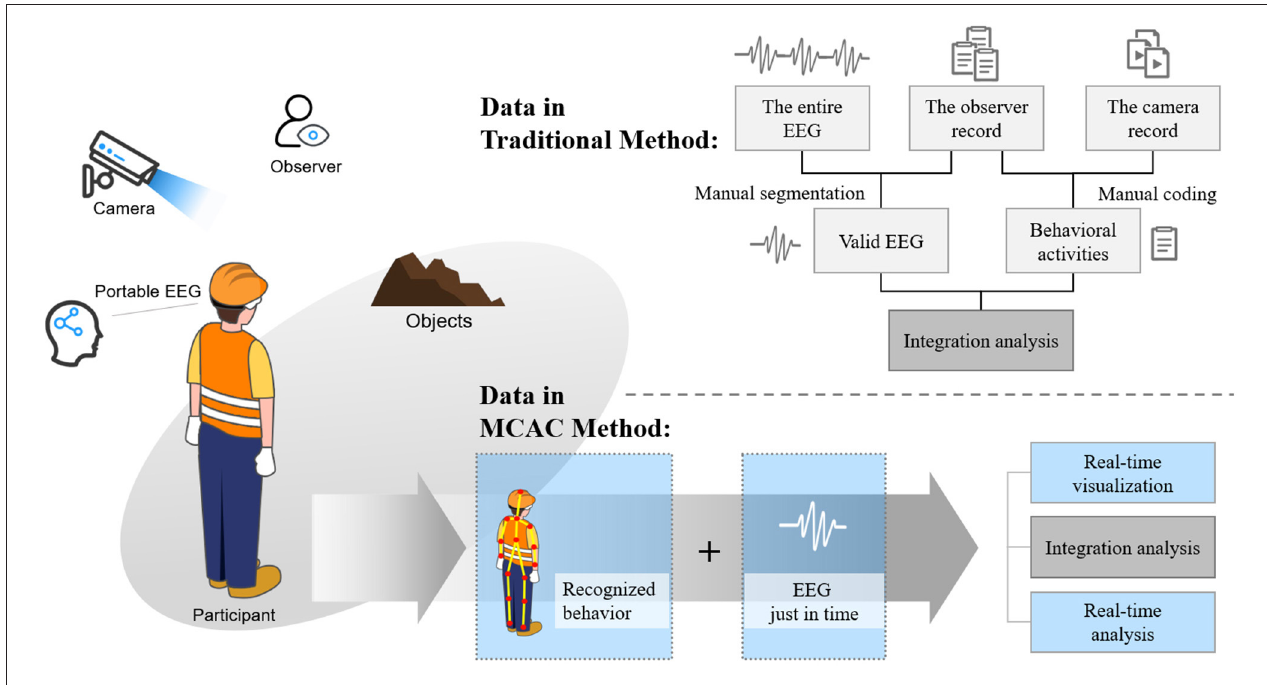
FIGURE 9 | The comparison of MCAC and conventional method in the same